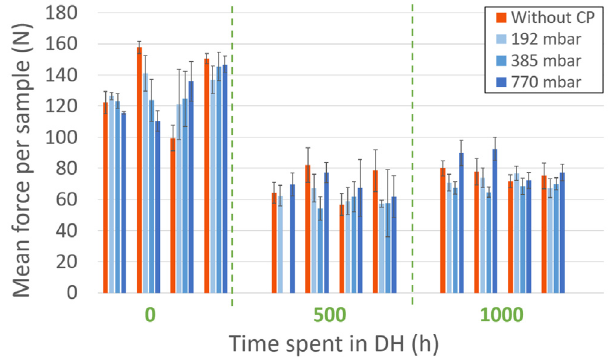
Fig. 8. Peeling test results per sample. Each column is the average of 3 strips. 4 samples were tested at each ageing point.